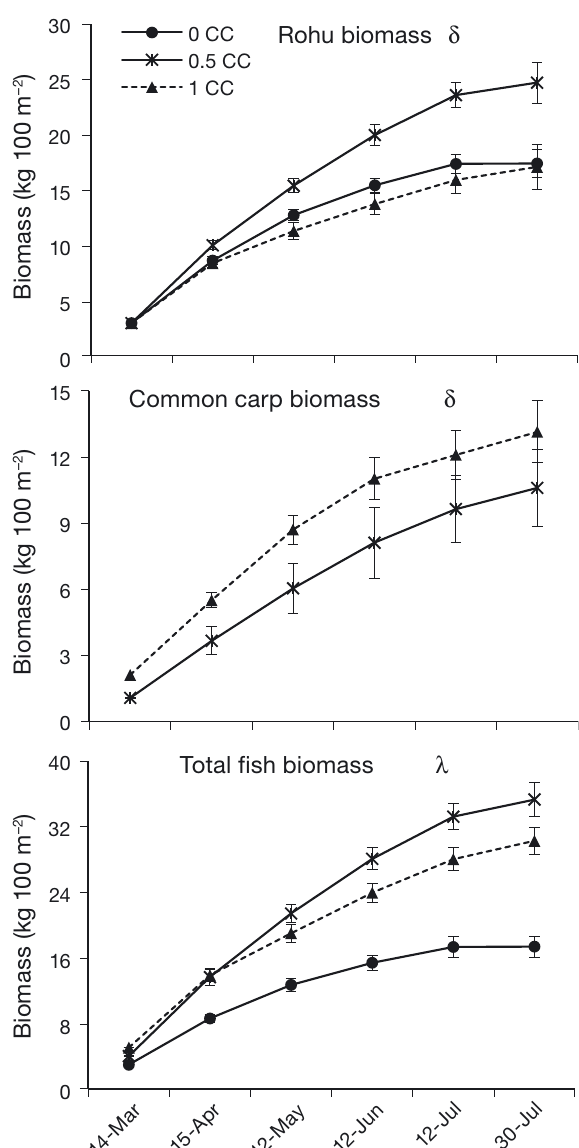
Fig. 6. Changes of fish biomass in ponds with different com- mon carp (CC; Cyprinus carpio) densities. Data are means (±SE). 0 CC, 0.5 CC and 1 CC indicate the ponds without common carp, with 0.5 common carp m −2 , and with 1 com- mon carp m −2 , respectively. δ indicates that the ponds with 0.5 common carp m −2 are significantly different from the ponds with 1 common carp m −2 and the ponds without com- mon carp. λ indicates that the ponds without common carp, with 0.5 common carp m −2 , and with 1 common carp m −2 are significantly different from each other (p < 0.05)